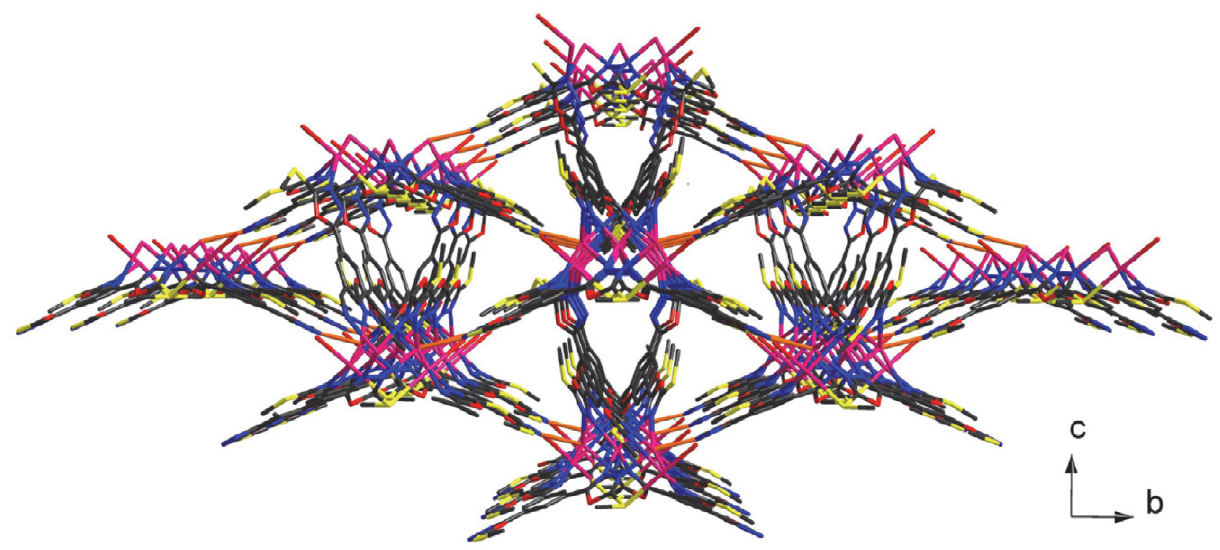
Figure 7. View of 3D network of 2 along a axis (anions and THF molecules are omitted for